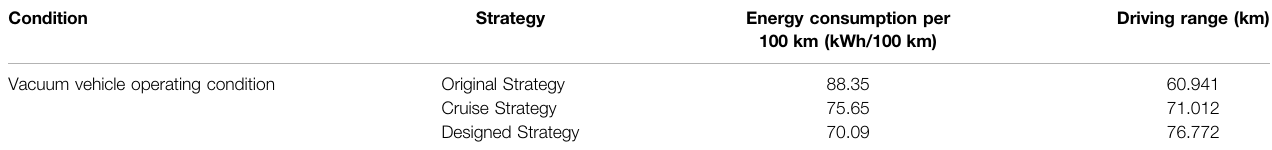
TABLE 5 | Comparison of energy consumption per 100 km and driving range.